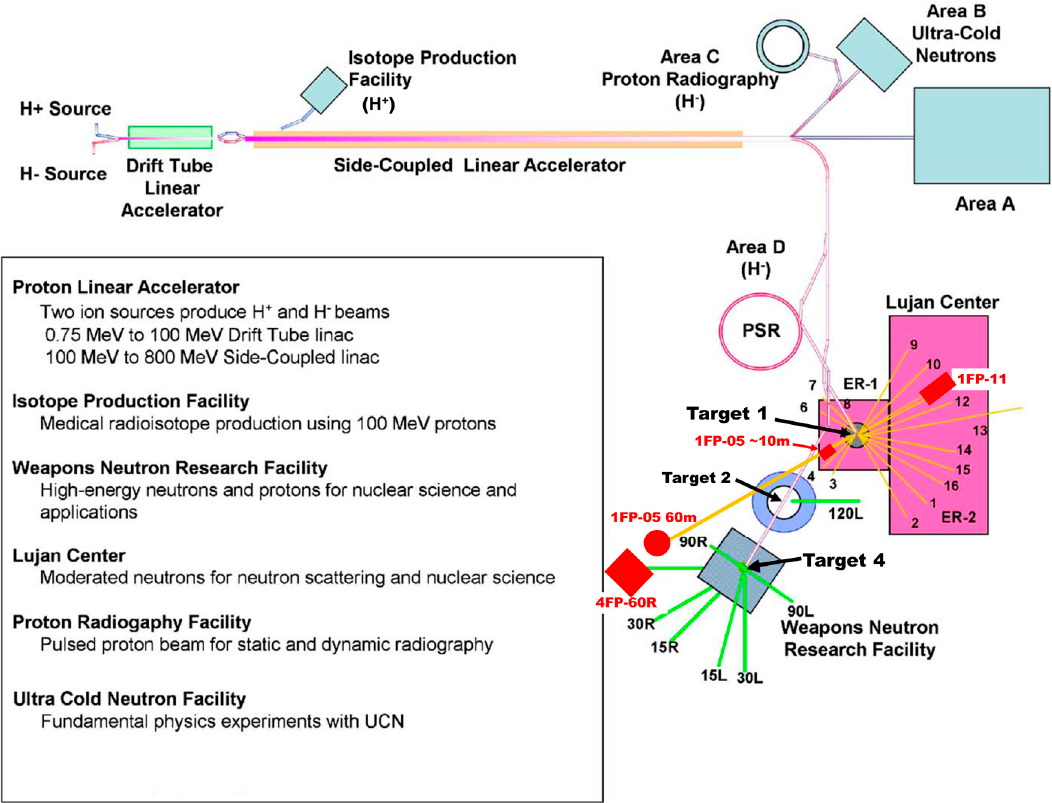
Figure 2. Overview of the LANSCE facility (after [32]). The imaging beamlines discussed here are flight paths 5 and 11 off of Target 1 in ER1 and 60R off of Target 4 at the Weapons Neutron Research facility (WNR), all shown in red. Table 1. Neutron-imaging beam line characteristics at LANSCE. Values shown are typical. Flight Path/Instrument